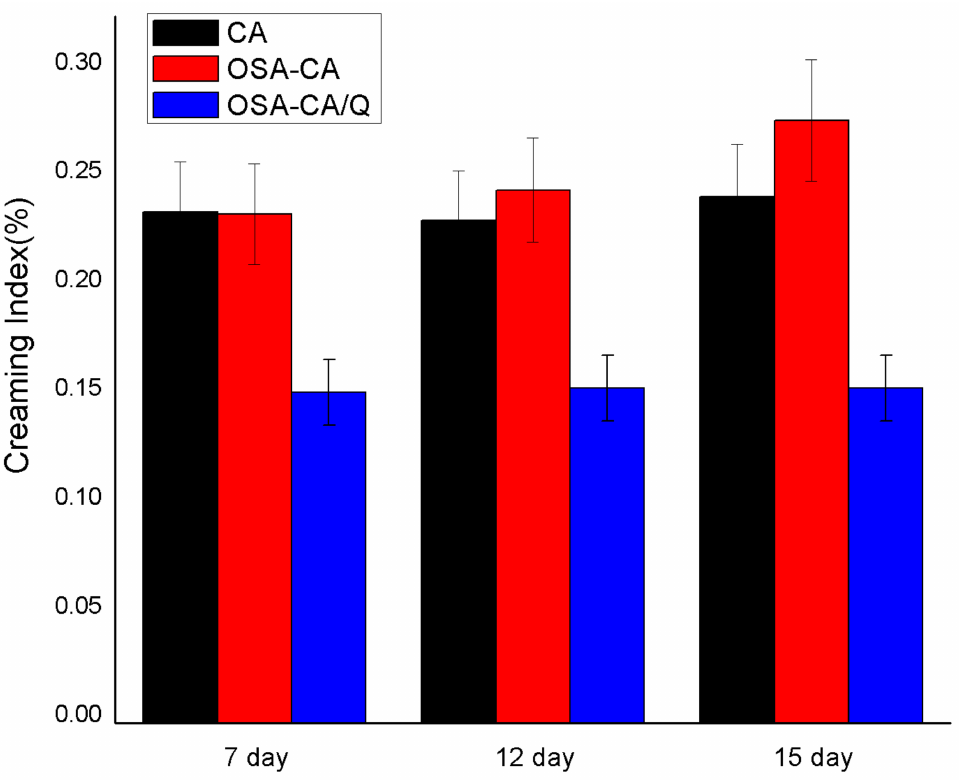
Figure 6. Evolution of the percentage of the creaming index (CI%). Table 1. POV values of emulsions with different